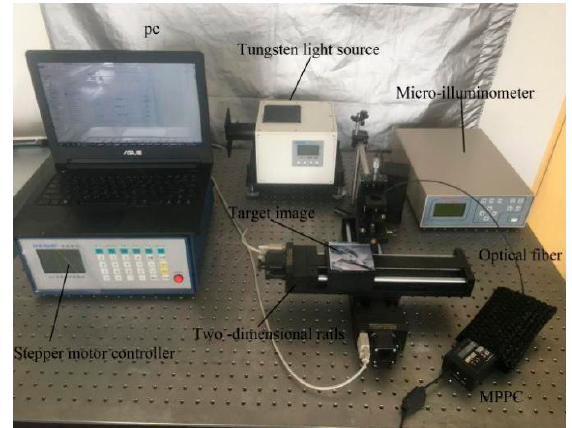
Figure 4. Principle diagram of optic experiment platform.